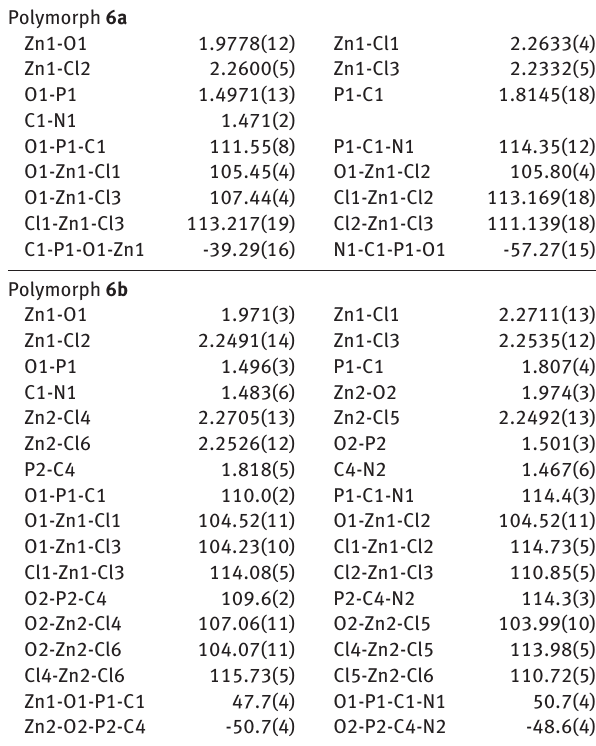
Table 1: Selected bond lengths (Å) and angles ( ° ) for 6a and 6b